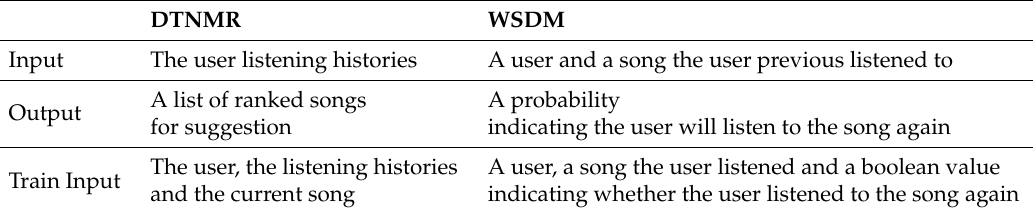
Table 3. The differences of DTNMR and WSDM challenge.